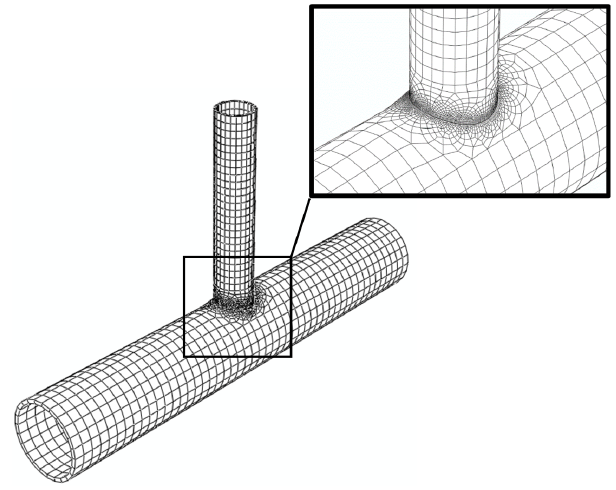
Figure 3. Finite element mesh of the J1 model.